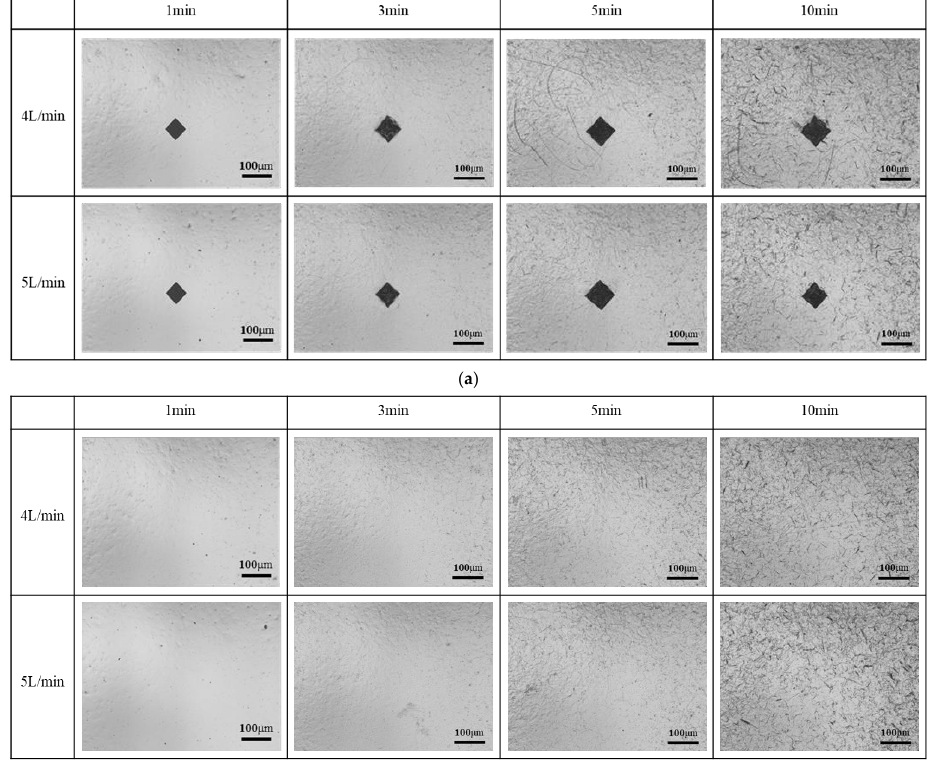
Figure 9. The number and size of microbubbles was near the specimen with different air-flow rates.